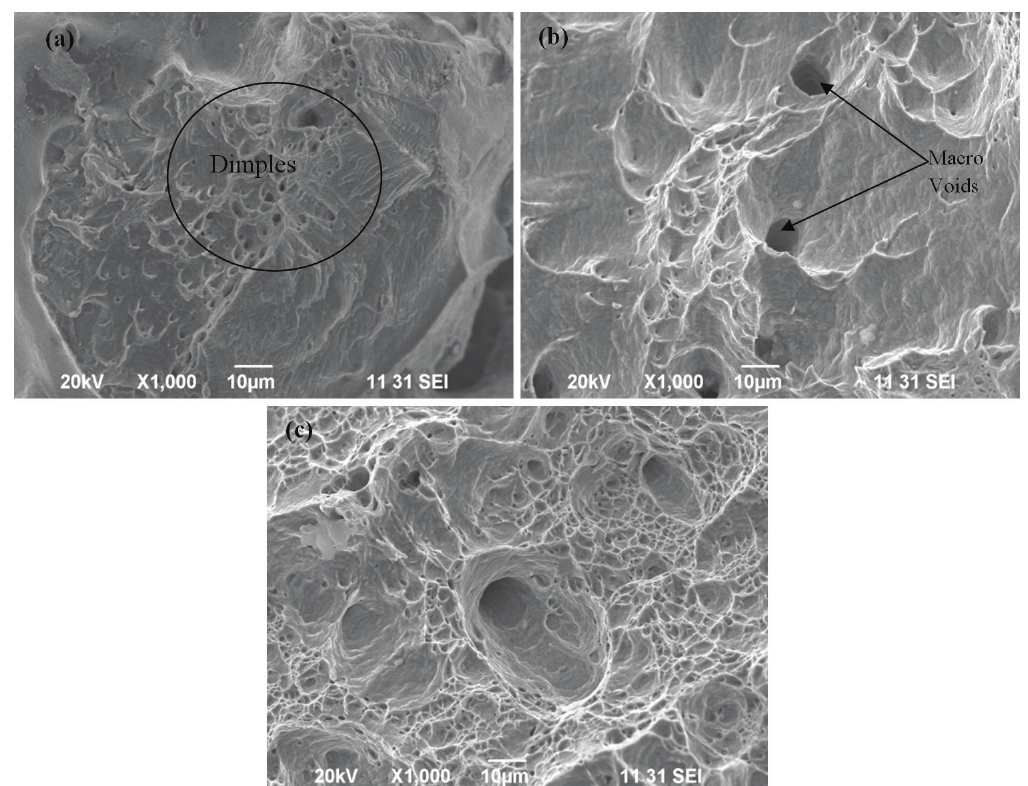
Figure 6. SEM fractographs of the PCGTA welds of dissimilar Monel 400 and AOSO 304 using (a) ER309L (b) ERNiCu-7 (c)